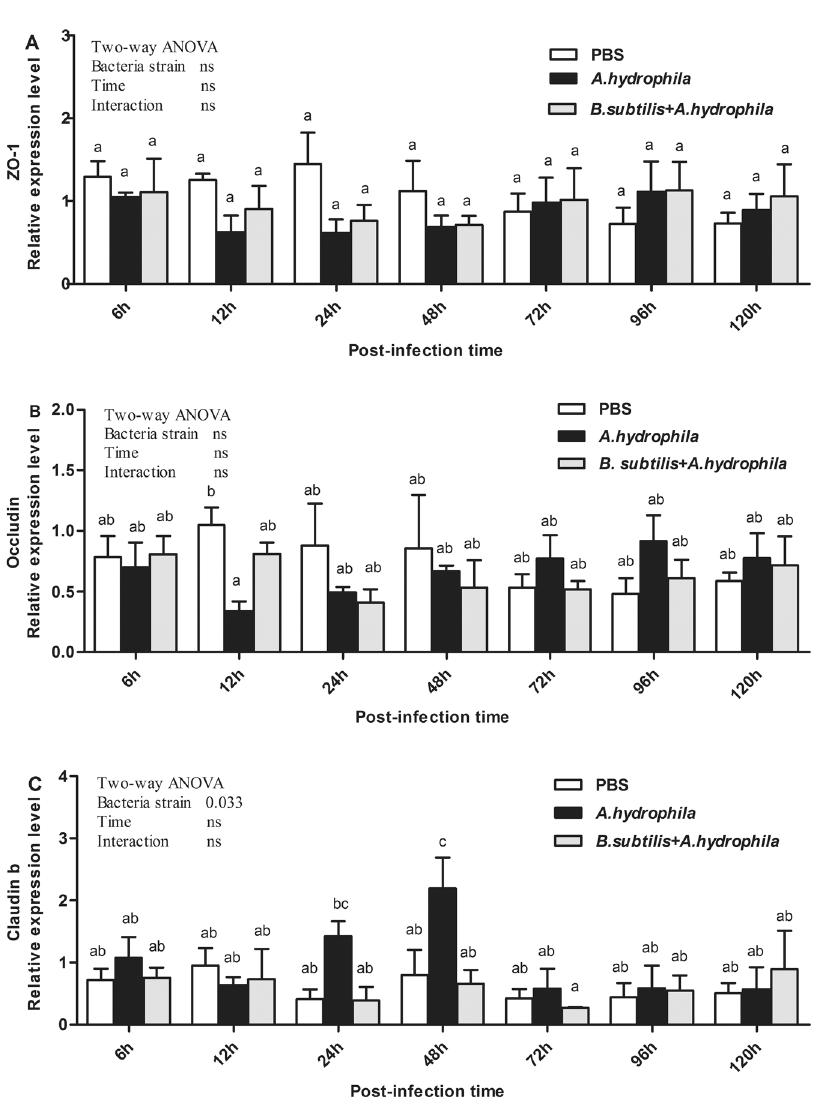
Figure 4. Relative expression of TJ proteins in the intestinal tissue after infection with A. hydrophila . Results shown are Mean ± SD (n = 6). ZO-1: zonula